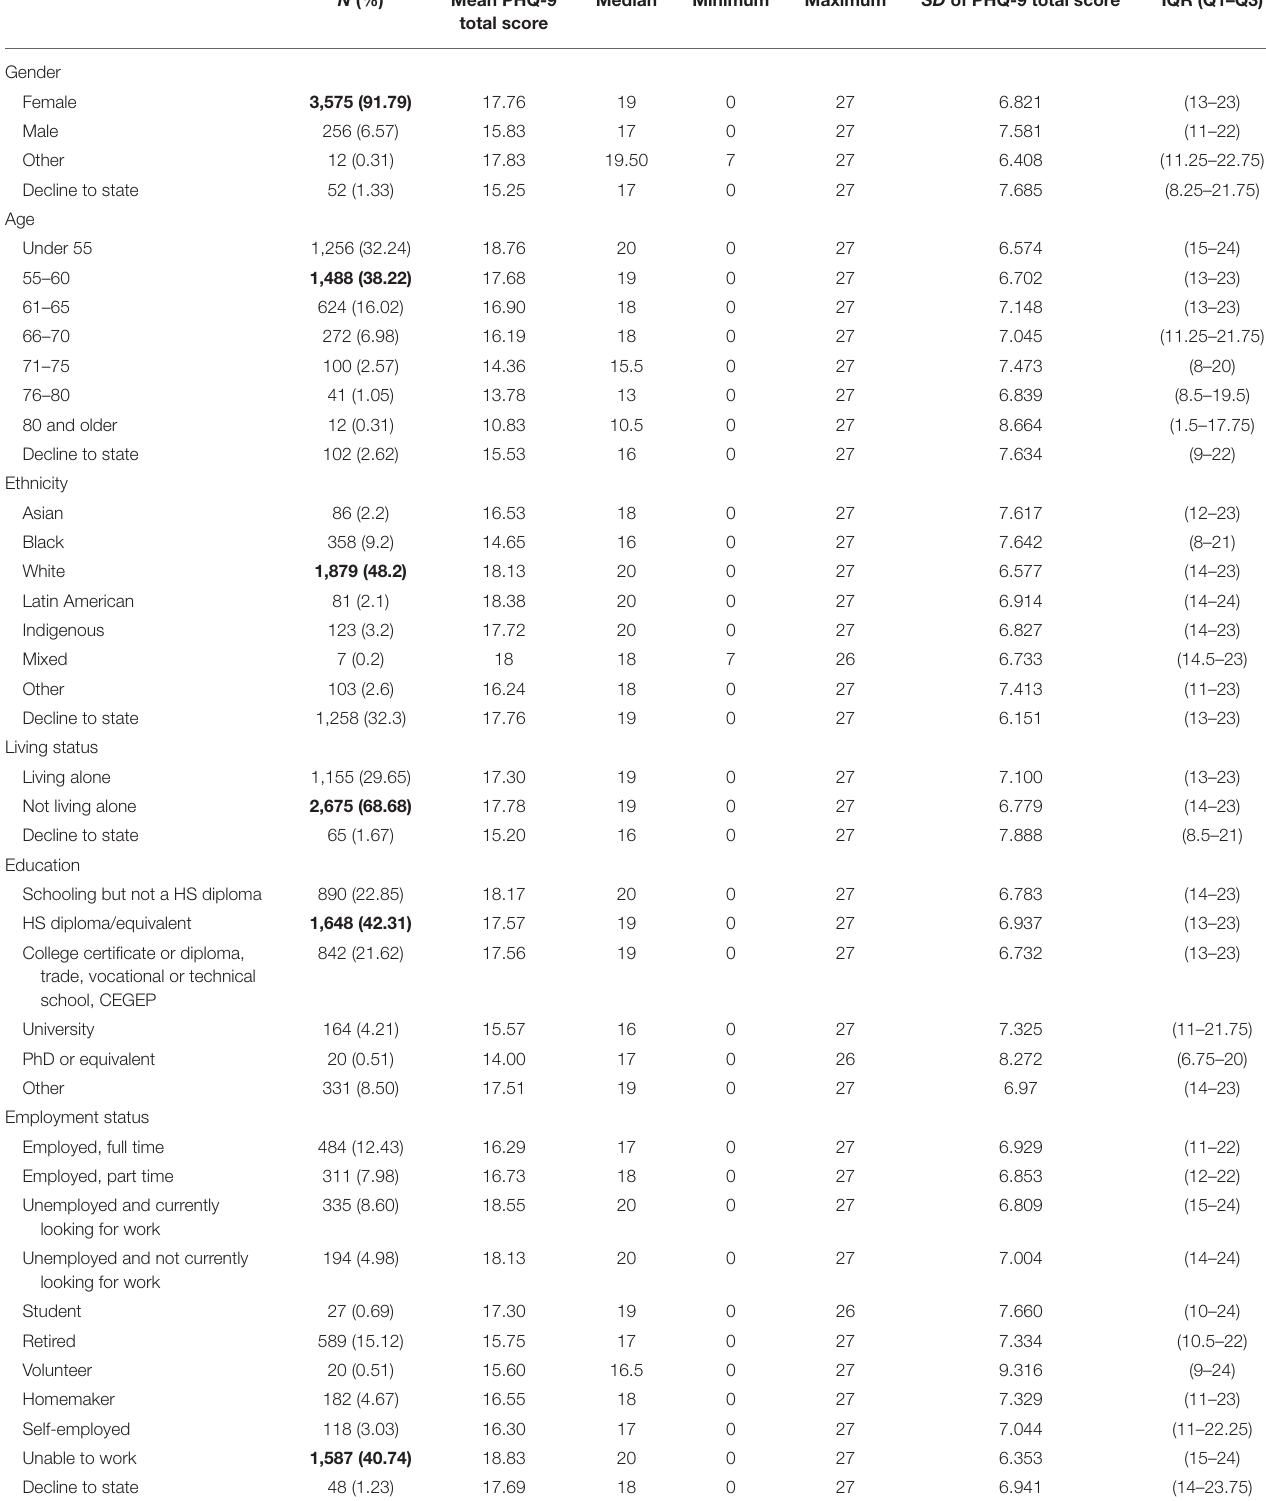
TABLE 1 | Demographic characteristics (total N =